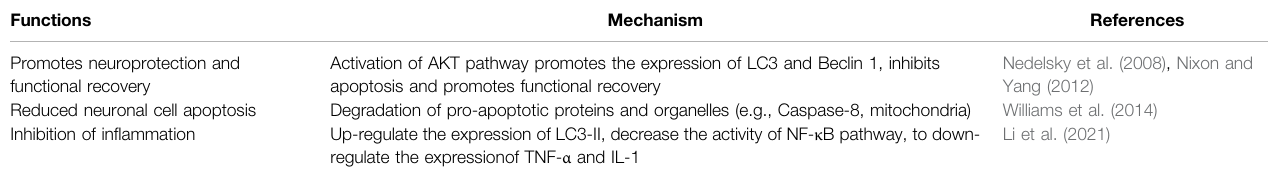
TABLE 1 | The bene fi cial effects of autophagy on SCI.